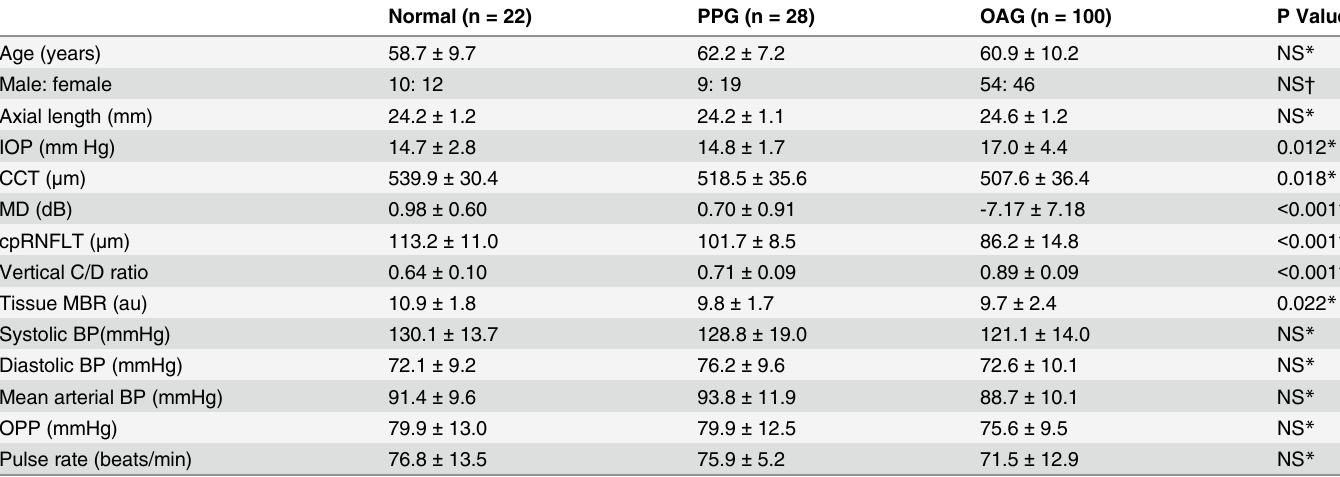
Table 1. Demographic data for this study. D: diopter. IOP: intraocular